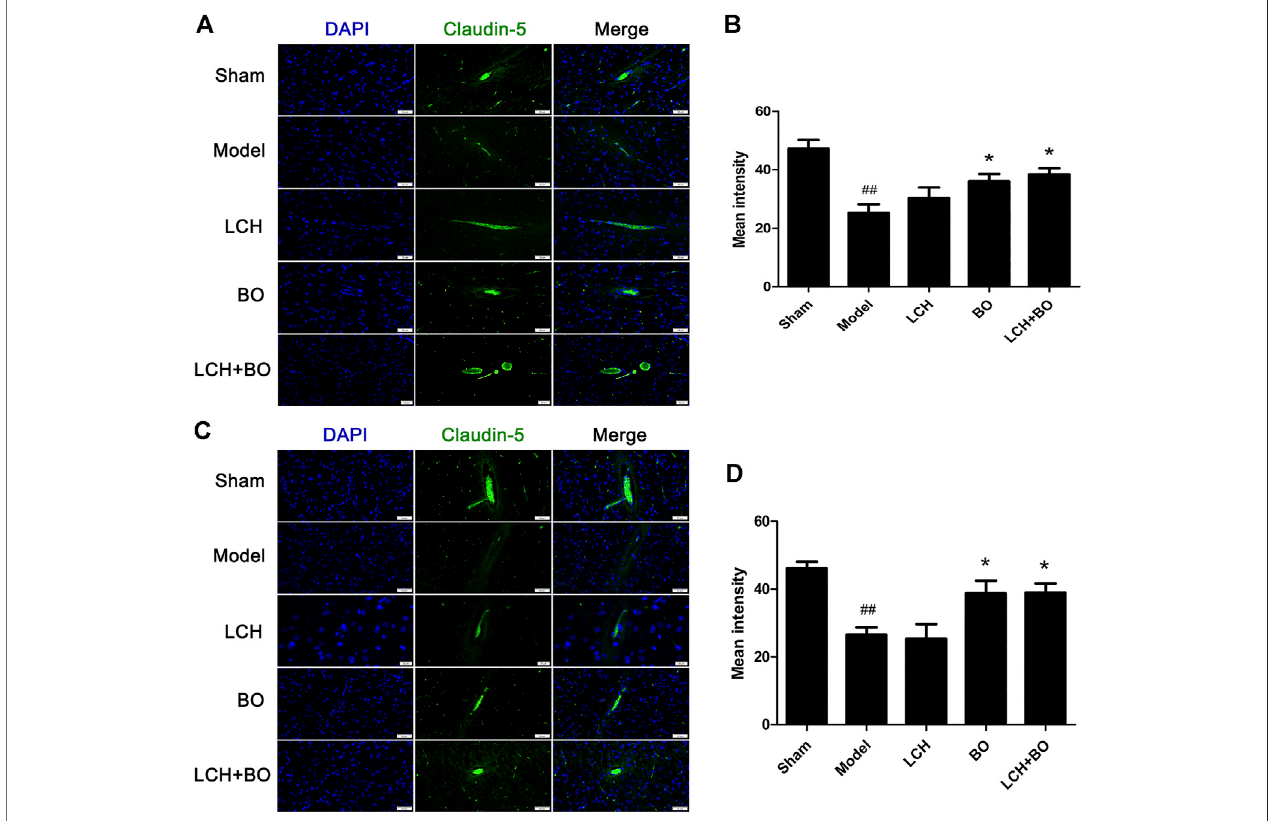
FIGURE10| Expressions ofclaudin-5withinDG and SVZ ofMCAOrats. (A) Representative immunostaining images ofclaudin-5 inthe DG area. (B) Theresults of average fl uorescence intensities of claudin-5 in the DG area ( n (cid:1) 3). (C) Representative immunostaining images of claudin-5 in the SVZ area. (D) The results of average fl uorescence intensities of claudin-5 in the SVZ area ( n (cid:1) 3). ## p < 0.01 compared to the sham group; * p < 0.05 compared to the model group.